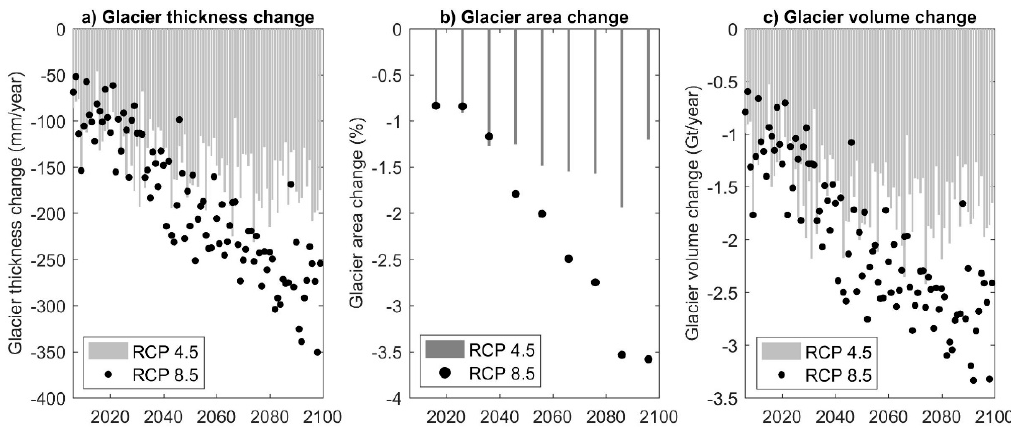
Figure 4. Future changes in glacier: thickness ( a ); area ( b ); and volume ( c ), for RCP 8.5 (MM85) and RCP 4.5 (MM45). The increasingly negative rate of glacier loss is statistically significant for both scenarios (Mann Kendall, p < 0.05).